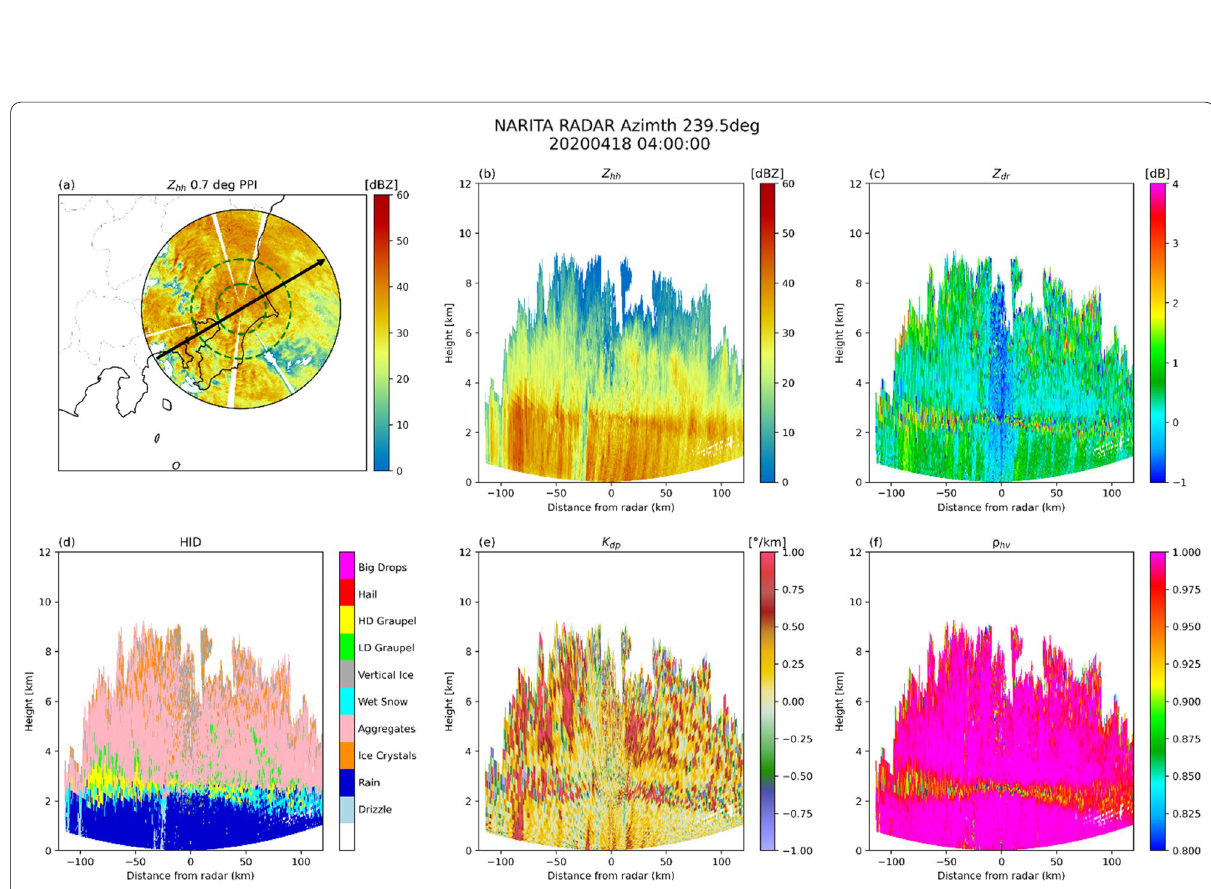
Fig. 6 Radar observation by the Narita radar at 04:00 UTC, April 18, 2020. Top row: a horizontal distribution of radar reflectivity [dBZ] (elevation angle 0.7°), vertical cross sections of b radar reflectivity Z hh [dBZ] and c differential reflectivity Z dr [dB]. Bottom row: vertical cross sections of d cloud types, e specific differential phase K dp [° km − 1 ], and f copolar correlation coefficient ρ hv . The vertical cross section is located along the straight line in the upper left figure (azimuth angle